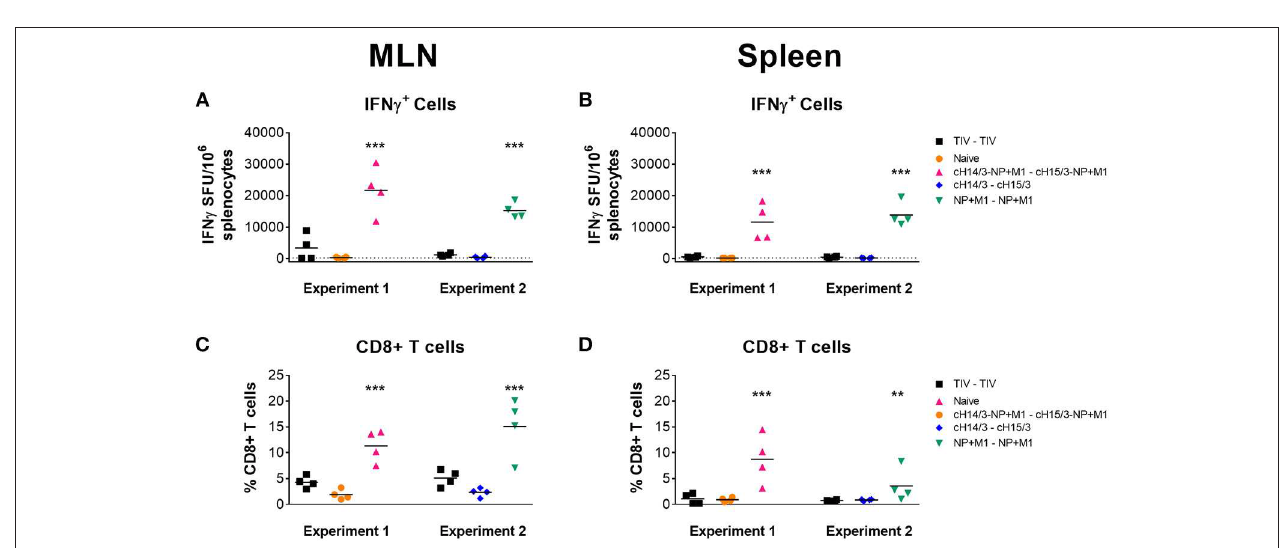
FIGURE 6 | IFN γ cellular responses in the MLNs and spleen. TIV vaccinated, viral vector vaccinated (cHA-NP + M1, cHA, or NP + M1), and naïve ferrets were challenged IN with 10 6 PFU of A/Wyoming/03/2003 (H3N2) virus and at 4 days post-challenge, ferrets were euthanized, and spleens and MLNs were removed to enumerate influenza virus-specific cellular responses. Splenocytes and MLN cells were stimulated with peptide arrays spanning the NP + M1 fusion protein and influenza virus-specific IFN- γ expressing cells were detected in the MLNs (A) and spleens (B) by ELISpot. The ICS assay was also used to detect influenza virus-specific IFN γ + CD8 + T cells in the MLN (C) and spleen (D) . The data are presented as individual replicates and the mean for each group is presented as line. n = 4 ferrets/group. ** p ≤ 0.01, *** p ≤ 0.001 when naïve controls were compared to individual vaccination groups as determined by one-way analysis of variance, followed by a Bonferroni multiple-comparison